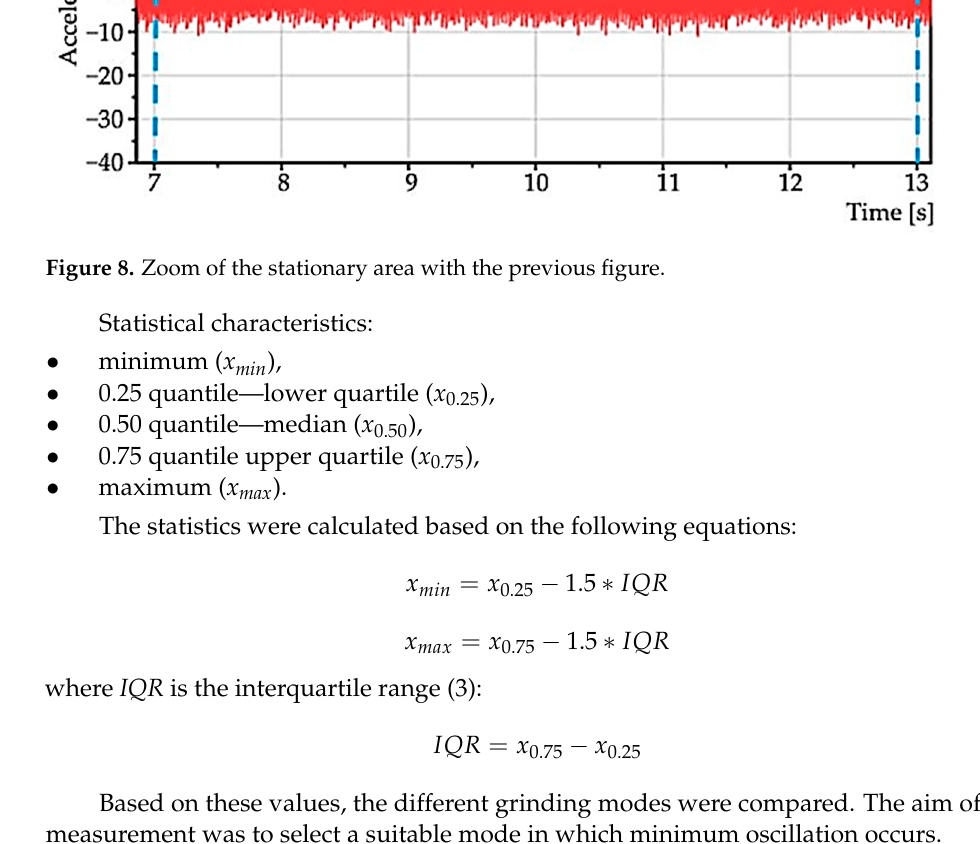
Figure 7. Acceleration values from one whole mode measurement.